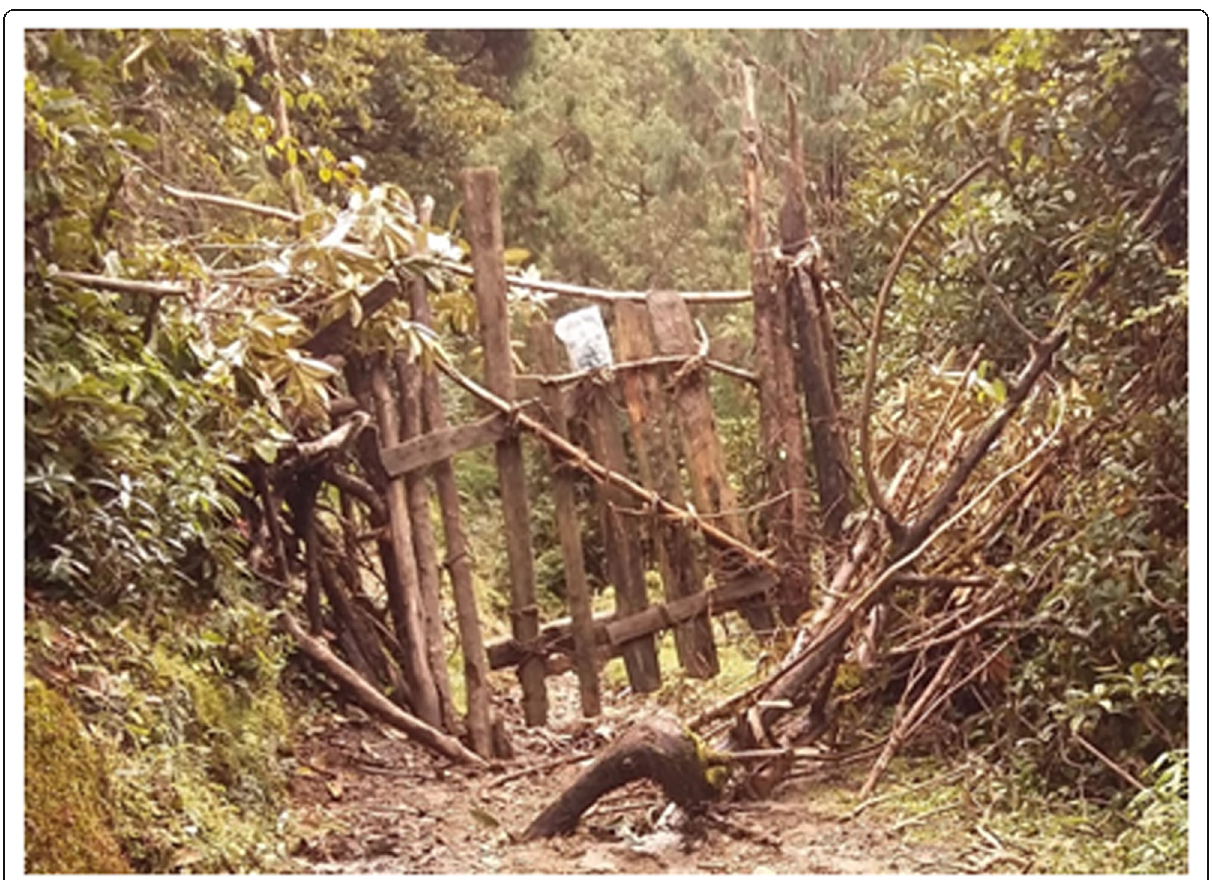
Figure 3 Gaag on Merak-Sakteng